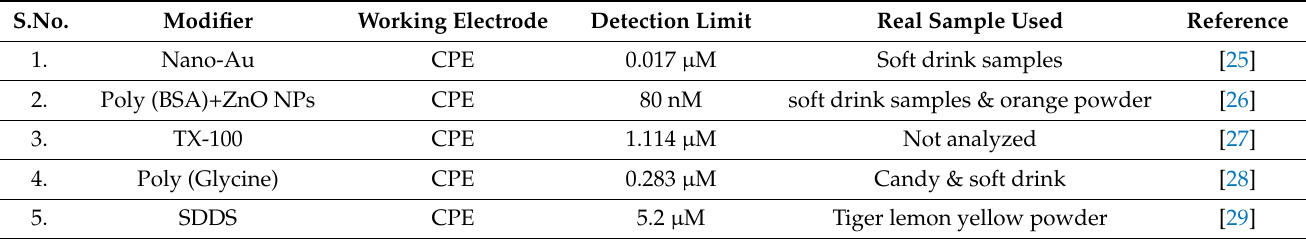
Figure 6. CVs of 1.5 µmol L − 1 Tartrazine in pH 4.0 phosphate buffer at CPE (curve A), nano Au- CPE (curve B), and nano Au-CPE at pH 4.0 without Tartrazine (dash line), scan rate = 100 mVs − 1 . Reprinted with the permission of Reference [25]. [License Number 5067491496844]. Table 3. Table showing Tartrazine detection using carbon paste electrodes with different modifiers along with their detection limits.